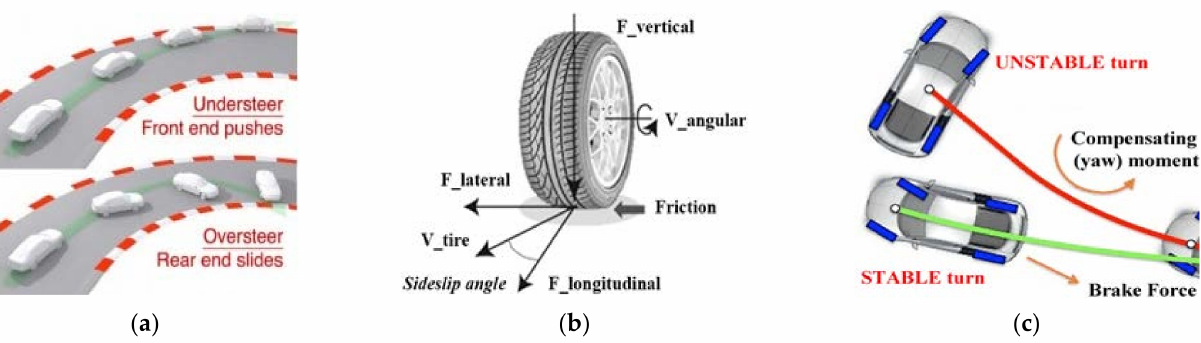
Figure 13. Summary of theoretical underpinnings for each GBL intervention: ( a ) impacts of oversteer versus understeer [50]; ( b ) primary tire parameters associated with vehicle sideslip [51]; ( c ) stable (green) versus unstable (red) braking trajectory scenarios, resulting from the yaw moment